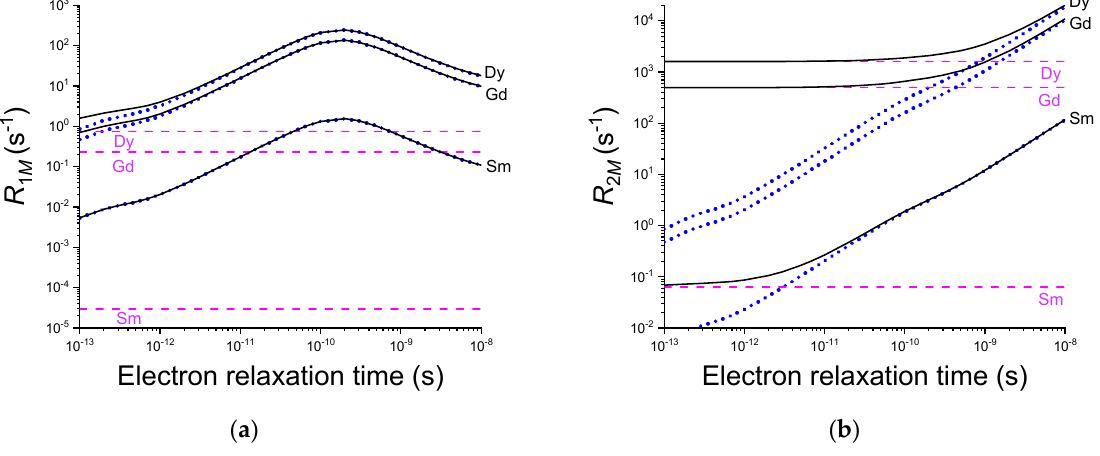
Figure 5. Solomon (dotted blue lines) and Curie (dashed pink lines) contributions to nuclear longitudinal ( a ) and transverse ( b ) paramagnetic relaxation (solid black lines) as a function of the electron relaxation time for samarium(III), gadolinium(III) and dysprosium(III). A non-exchangeable 1 H nucleus was considered at a distance r = 10 Å from the paramagnetic metal, in a molecule with a reorientation time τ R = 10 ns , in a magnetic field of 900 MHz proton Larmor